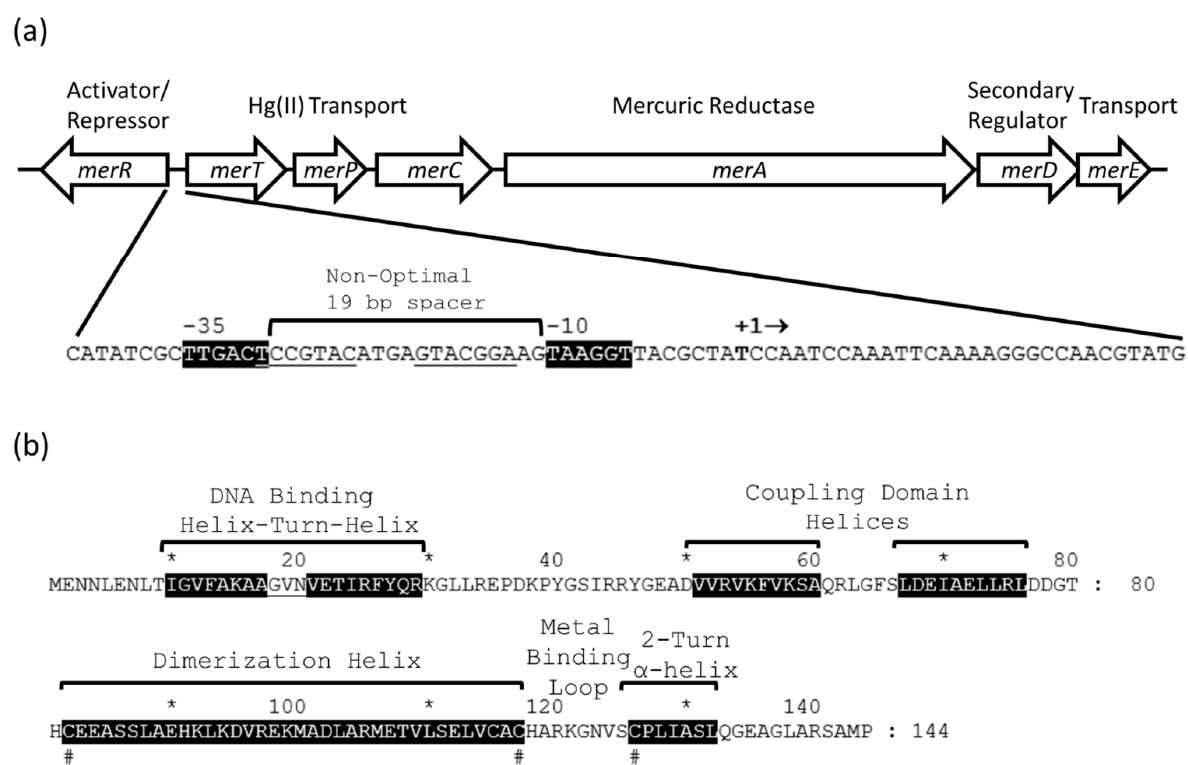
Figure 1. The Tn 21 mercury resistance ( mer ) operon and MerR protein activator/repressor switch. ( a ) The genes merTPCAD are transcribed to the right and merR is transcribed to the left. The MerR protein binds as a dimer to the DNA operator region (underlined) between the − 10 and − 35 RNA polymerase binding regions (highlighted in black). The non-optimal 19 base pair (bp) spacer between the − 10 and − 35 regions prevents RNA polymerase from initiating transcription efficiently. In the absence of Hg(II), MerR binding to the DNA acts as an off switch to repress transcription. In the presence of Hg(II), MerR acts as an on switch by shortening the distance between and aligning the − 10 and − 35 regions so that RNA polymerase can initiate transcription of the merTPCAD genes efficiently. Transcription begins at the nucleotide base (bold) below + in +1. The first three base pairs, CAT, on the far left marks the beginning of MerR translation. The last three base pairs, ATG, on the far right marks the beginning of MerT translation. ( b ) The Tn 21 MerR amino acid residue primary sequence. The helix-turn-helix domain binds to the operator region of the promoter in the DNA. The coupling domain links the DNA binding domain to the metal binding domain. The metal binding domain consists of the dimerization helix, metal binding loop and 2-turn α -helix. The dimerization helix links two identical MerR polypeptides to form an antiparallel coiled coil. The # below the sequences designates conserved cysteine amino acid residues which bind to Hg(II). The * and numbers above the MerR primary sequence denote the position of every 10 amino acid residues.